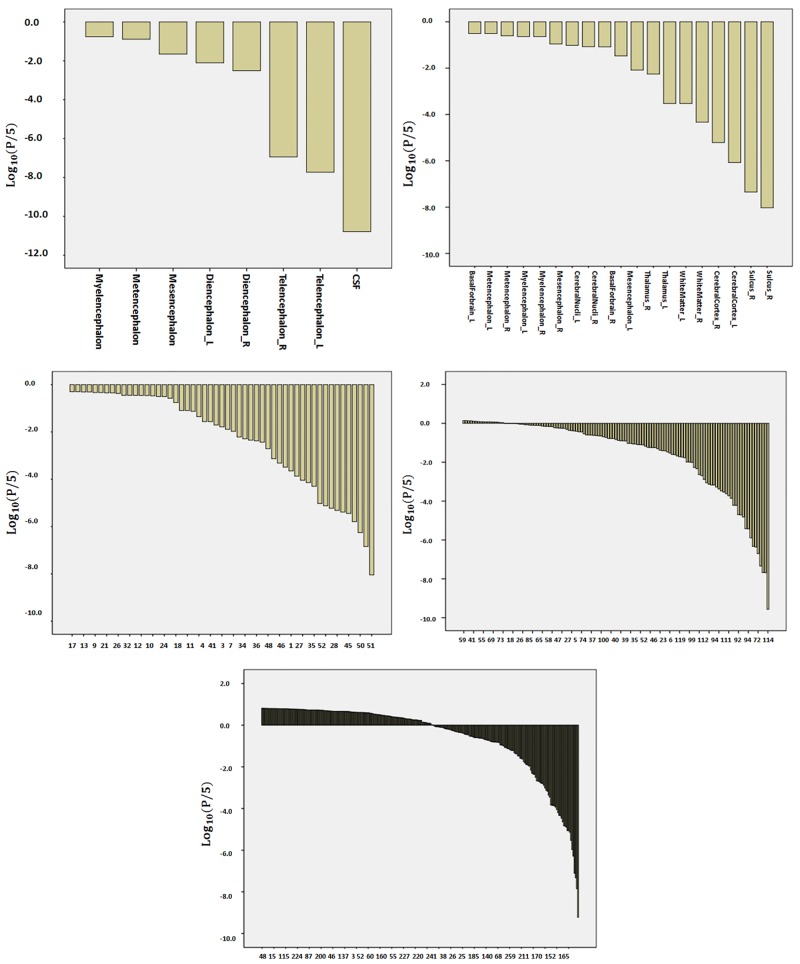
Distribution of Bonferroni-corrected p-values from the correlation between age and regional volumes.All the granularity levels are shown. For better visualization, the P values are presented as Log10(P/5). Therefore, p<0.05 corresponds to <-2 on the y-axis.